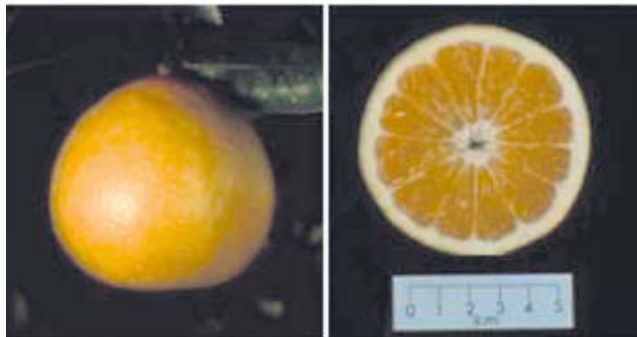
Fig. 3 - Female-sterile seedless citrus ‘Southern Yellow’.